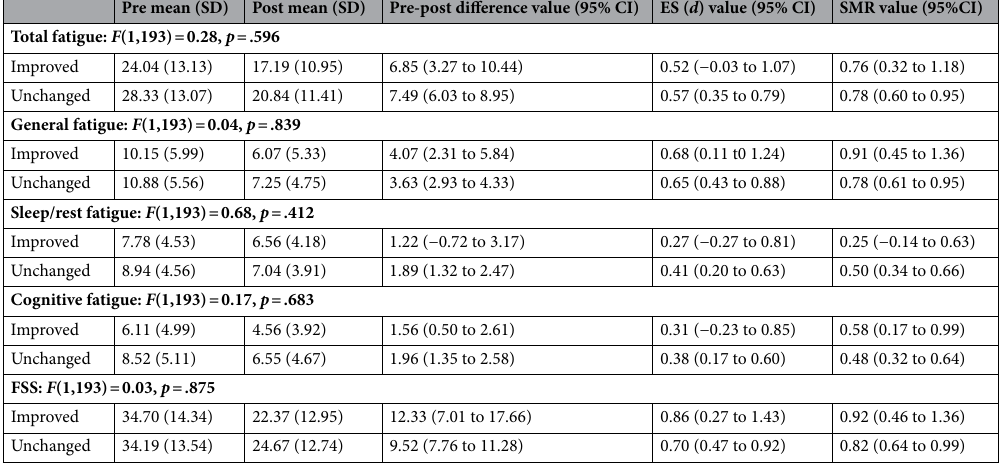
Pre mean (SD) Post mean (SD) Pre-post difference value (95% CI) ES ( d ) value (95% CI) SMR value (95%CI)